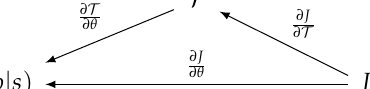
Figure 5. LA3 architecture: In the orchestrator (ORC), locality-aware action abstraction ( LA3 ) treats the object-wise scheduling task as a two-step procedure (as illustrated in the left-box of diagram). The second step ( T ( · ) | ρ ) is implemented based on either the user-defined function or the generative model-based function.